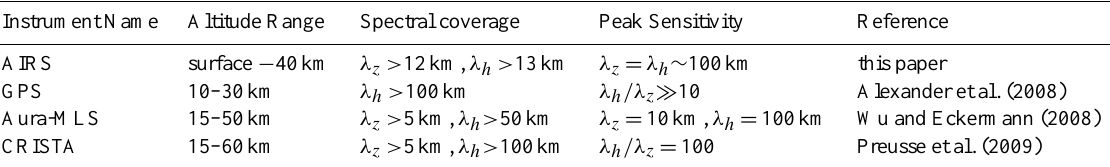
Table A1. Comparison of sensitivity to GW parameters from various satellite measurement techniques. Spectral coverage and sensitivity peaks depend on the techniques that are used in the corresponding